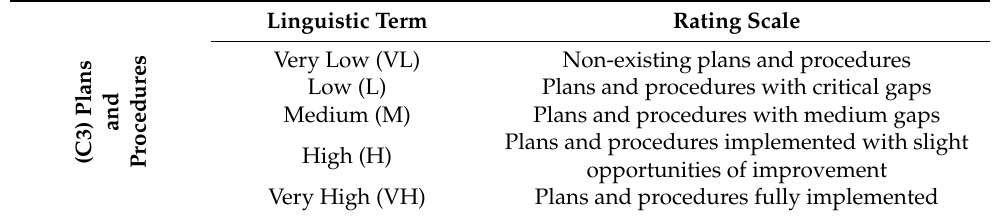
Table 5. Plans and procedures (C3) rating